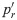
Probability of recombination of the second chromosome.(A) Decision tree of the recombination process for one chain (α or β). The first part shows the recombination of the first chromosome, the second part of the second chromosome. In each area a binary choice is made. Red crosses indicate decision outcomes that lead to no observed sequence. Observable outcomes (with at least one coding sequence) are indicated at the end of the tree by green ticks. C stands for coding, nC for non-coding. (B) Bounds on the allowed values of rescue probabilities for the β chain calculated from the decision tree in (A). The black part of the graph corresponds to the allowed values of pr′ (probability of a second recombination for β if the first was successful) and pr (probability of a second recombination for β if the first was not successful). The bounds were obtained by imposing 0<pfβ<1 in Eq 1. (C) Bounds on the allowed values of rescue probabilities for the α chain. They are consistent with both chromosomes recombining simultaneously and independently, pr=pr′=1.